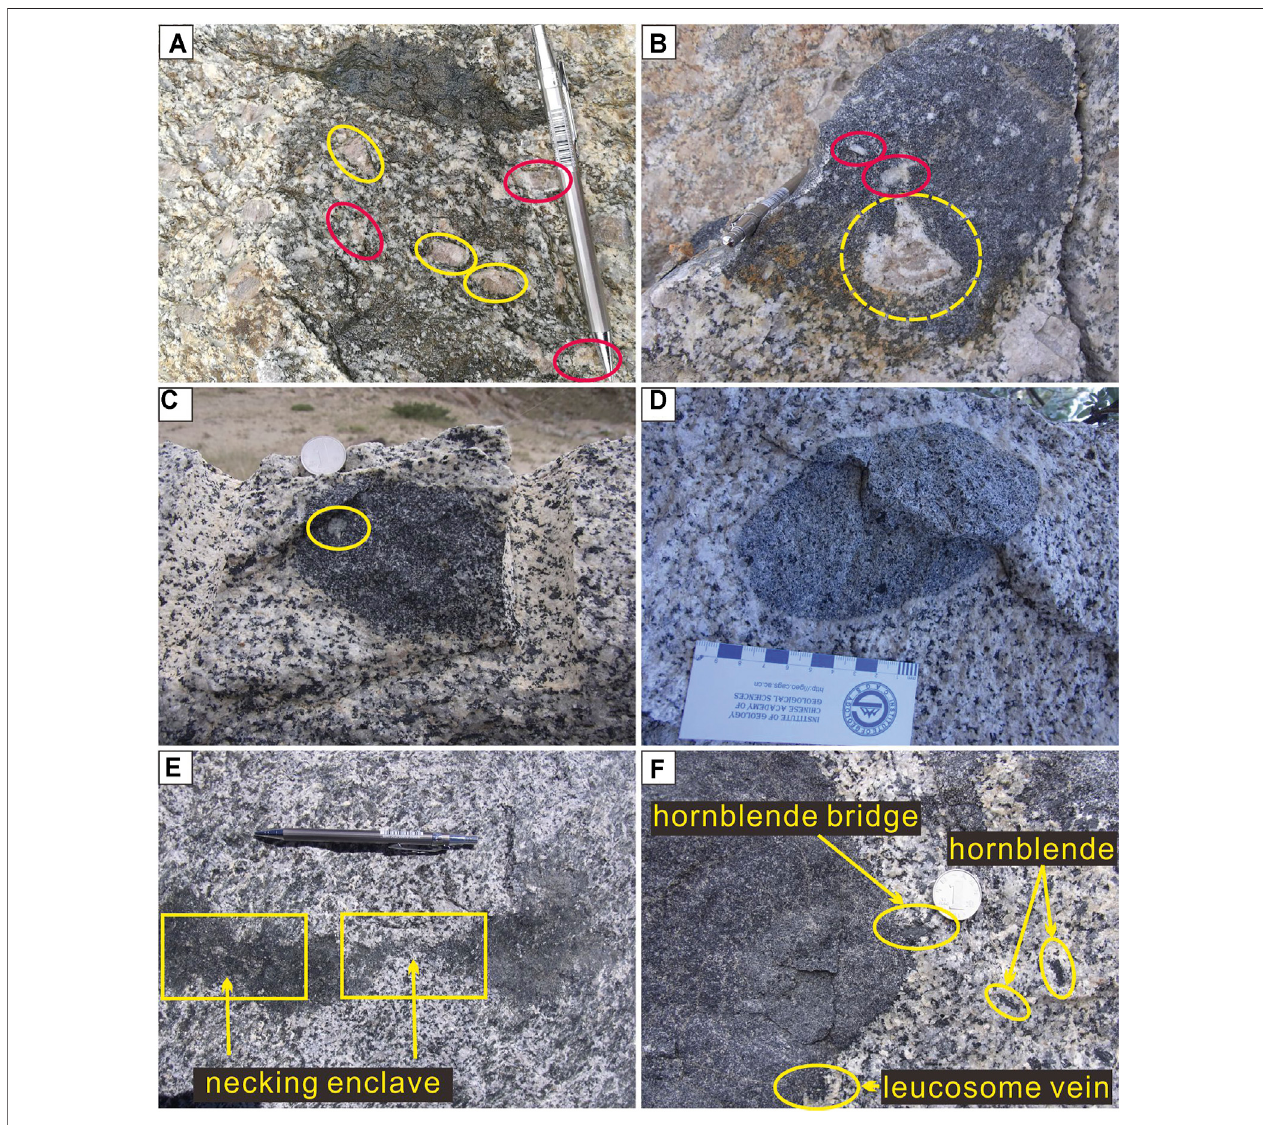
FIGURE 7 | Field photos showing the transfer and bridging of minerals from host magma into enclaves. (A,B) Large K-feldspar crystals within the enclaves were captured from the host monzogranite magma. (C) Plagioclase phenocrysts within the enclaves were captured from the host dioritic to granodioritic magma. (D) An enclave is mantled by a fi ne-grained leucocratic margin that is characterized by a trachytic texture. This leucocratic margin will prohibit further chemical and mineral exchange. (E) An enclave subjected to necking, indicating that the enclave deformed plastically within the host granitoid magma. (F) Large hornblende crystal is connecting the enclave and the host, referred to as “ hornblende bridge, ” indicating that both the enclave and the host rock were in the plastic state during hornblende growth. Minor leucosome veinis foundbetweenthe contrastingcomponents. Theleucosomewill inhibit further interaction between the enclave and the host granitoids. Euhedral hornblendes are scattered in the host